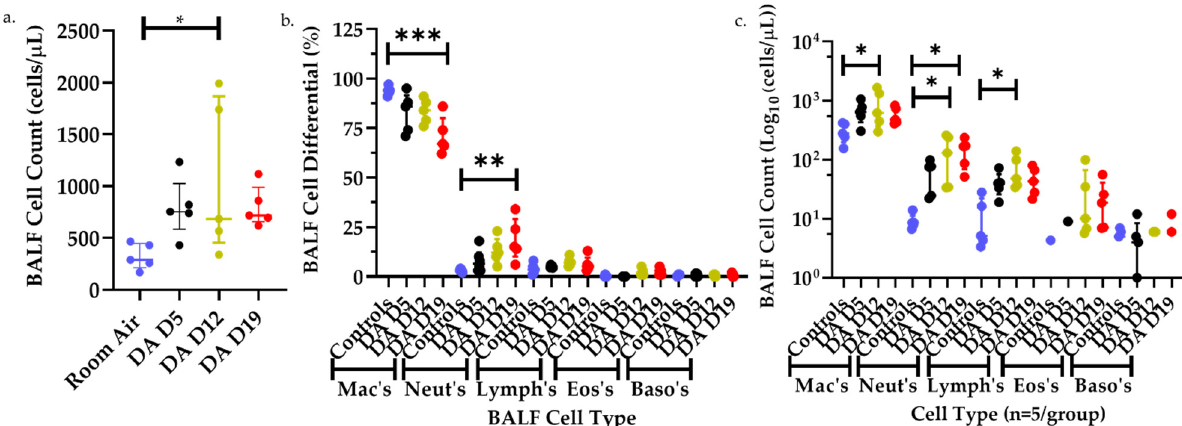
Figure 2. BALF total cell counts ( a ), percent cell differentials ( b ), and individual cell counts ( c ) from room air (blue), DA-exposed Day 5 (black), Day 12 (yellow), and Day 19 (red). ( a ) BALF total cell counts increased significantly in DA D12 compared to room air controls (Kruskal–Wallis, * p < 0.05). ( b ) BALF percent macrophages decreased significantly in DA D19 compared to room air controls (ANOVA, *** p < 0.001) while percent BALF neutrophils increased significantly in DA D19 rats compared to controls (ANOVA, ** p < 0.01). ( c ) Total BALF macrophages, neutrophils and lymphocytes increased significantly in DA D12 rats compared to controls (ANOVA, * p < 0.05), and BALF neutrophils increased significantly in DA D19 compared to controls (ANOVA, * p < 0.05).